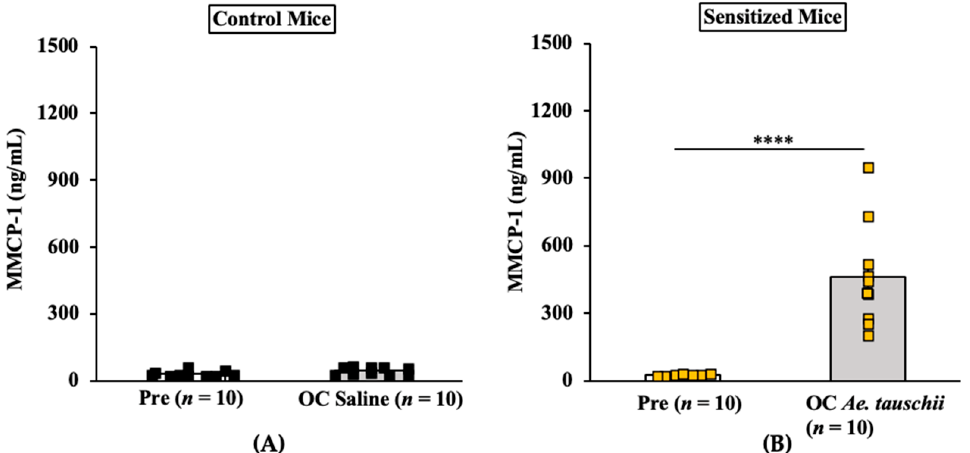
Figure 9. Oral challenge with SSPE from Aegilops tauschii elicits a robust mucosal mast cell response (MMCR) in Balb/c mice. Mice were sensitized and orally challenged with Ae. tauschii SSPE or saline as described in the Materials and Methods. Plasma levels of mucosal mast cell protease (MMCP)-1 (ng/mL) in pre- and 1-h post-challenge were measured by ELISA. ( A ) MMCP-1 levels in control mice challenged with saline. ( B ) MMCP-1 levels in allergic mice challenged with Ae. tauschii SSPE. **** p < 0.005, student’s t -test, n : number of mice, OC: oral challenge, SSPE: salt-soluble protein extract, ELISA: enzyme linked immunosorbent assay.